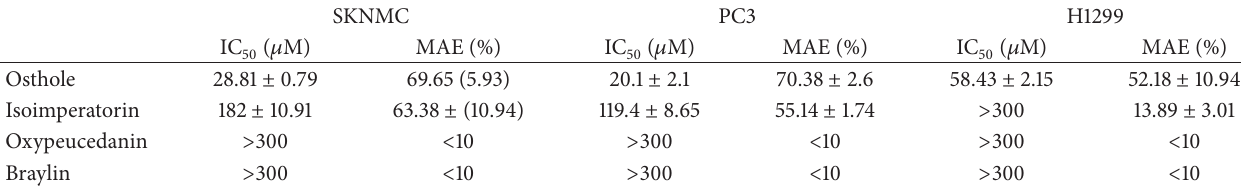
Table 1: Cytotoxic activity of coumarins isolated from Prangos ferulacea against human cancer cell